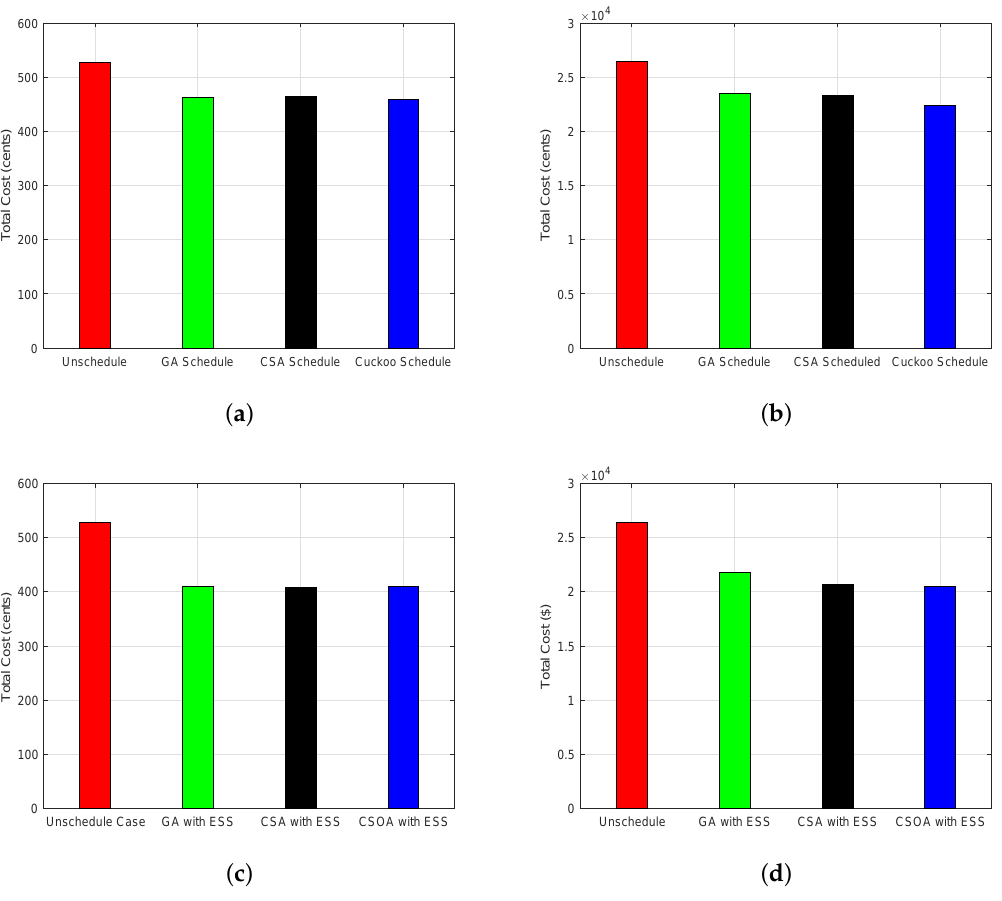
Figure 10. Total electricity cost using RTP signals. ( a ) Total electricity cost for a single smart home without ESS; ( b ) total electricity cost for 30 smart homes without ESS; ( c ) total electricity cost with ESS for a single smart home; ( d ) total electricity cost with ESS for 30 smart